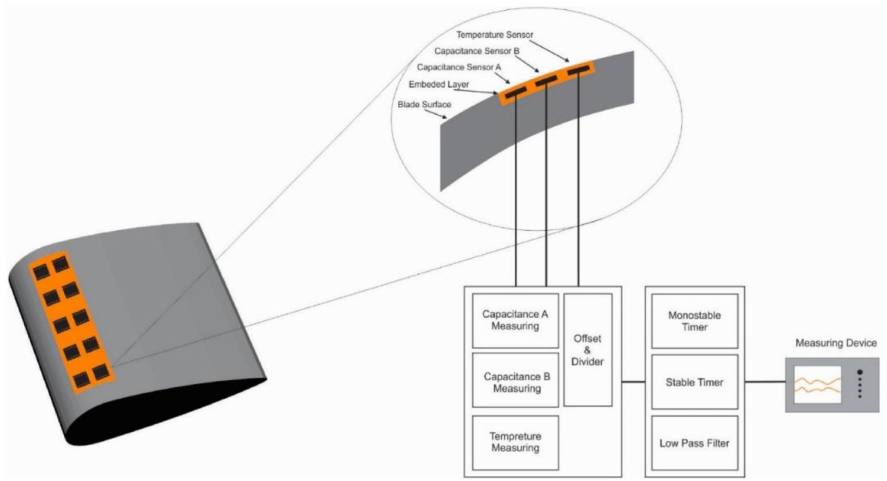
Figure 5. Schematic diagram of the implementation of capacitive ice sensing (reproduced with permission from Madi et al.